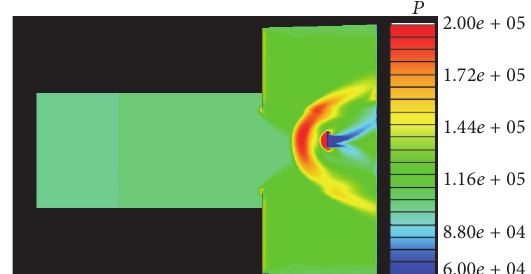
Figure 7: Computed surface pressure contours in the afterbody fin region near the microflap for a 1-flap case, 𝑀 = 2.5, 𝛼 = 0 ∘ .